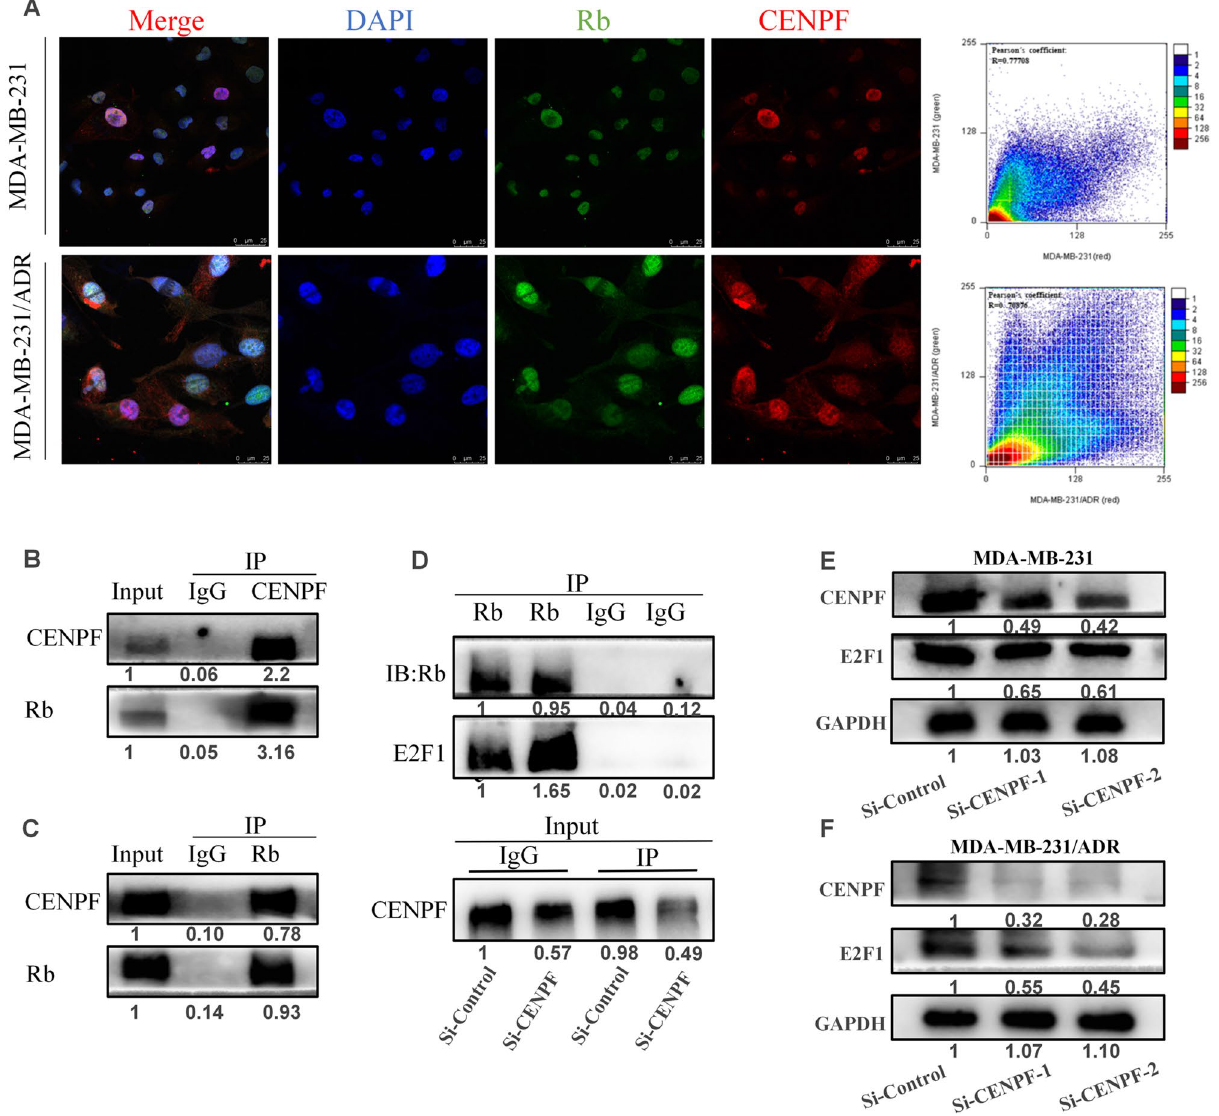
Figure 4. The Rb-E2F1 axis mediates the regulation of Chk1 expression by CENPF. ( A ) Colocalization of CENPF and Rb in MDA-MB-231 and MDA-MB-231/ADR cells. ( B , C ) Western blotting detected the binding protein of immunoprecipitated endogenous CENPF (B) or Rb (Rb). ( D ) Co-IP and western blotting demonstrated that CENPF and E2F1 compete for Rb binding. ( E , F ) Western blot analysis of the effect of CENPF knockdown on E2F1